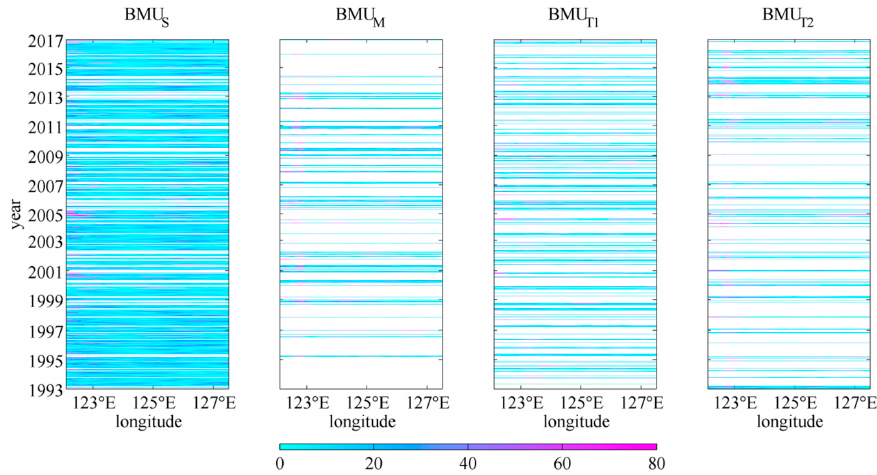
Figure 10. Temporal evolution of the winning element errors (unit: km) for different best matching units identified from the SOM analysis. The winning element error at every time must correspond to only one best matching unit (BMU) pattern, so it is vacant for the other three BMU patterns (white